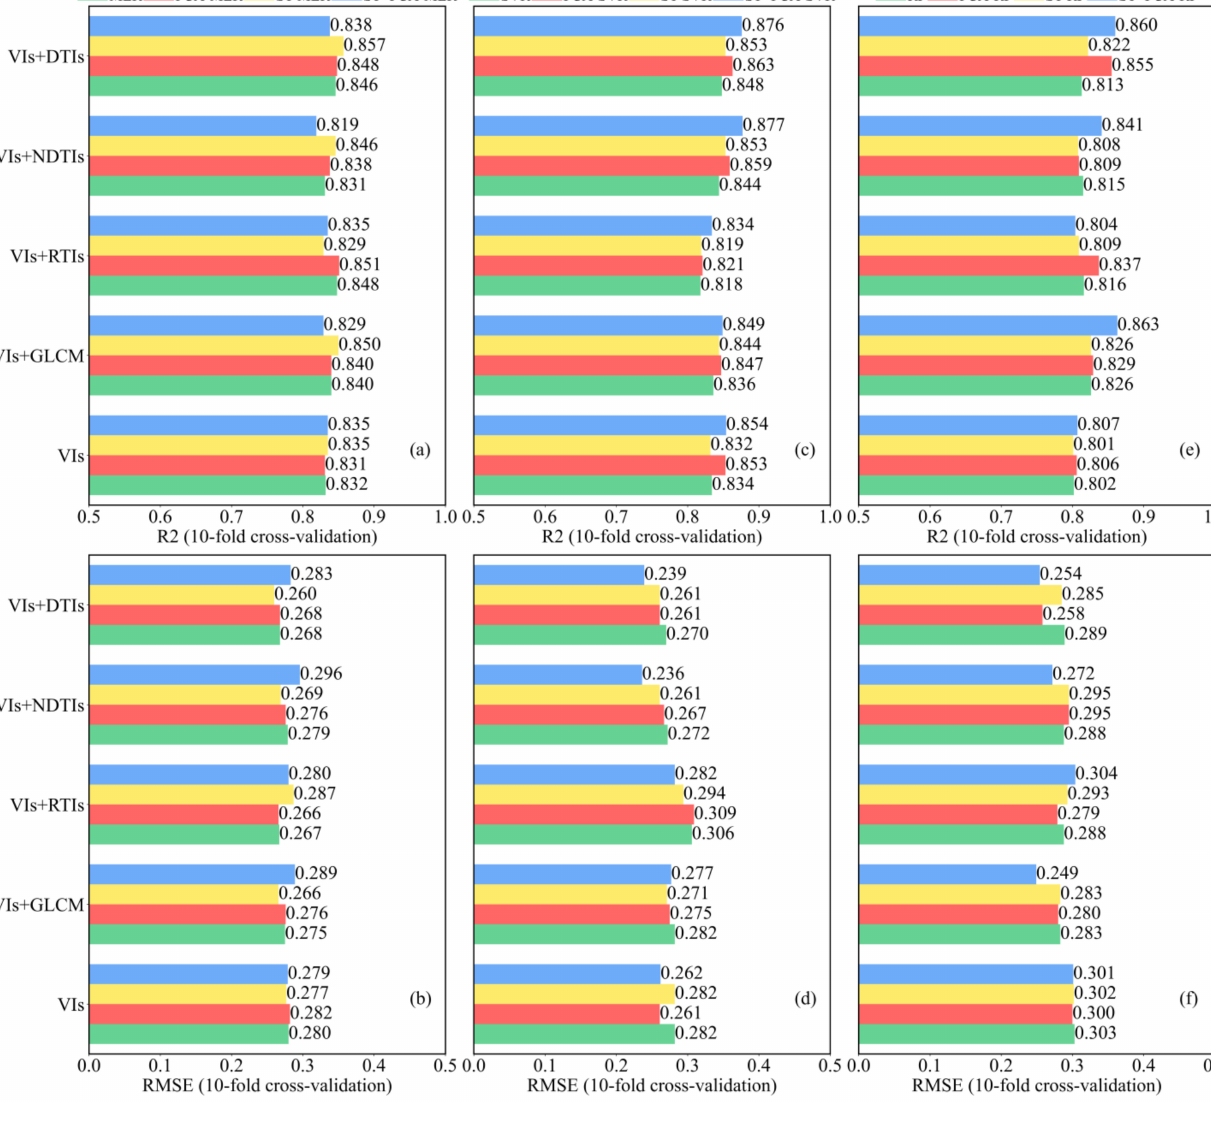
Figure 6. Ten-fold cross-validated R 2 ( a , c , e ) and RMSE ( b , d , f ) of multiple regression models for maize LAI